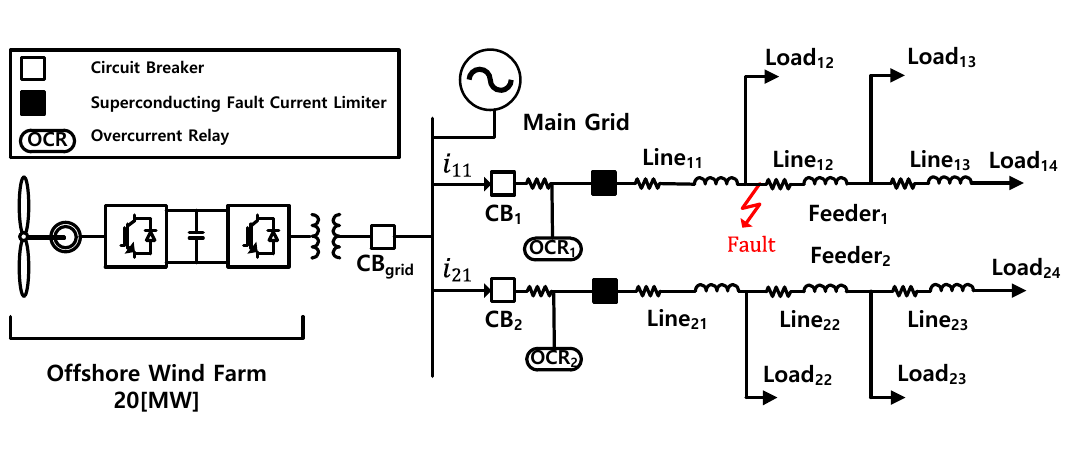
Figure 5. Configuration of offshore wind farm and grid connection with a superconducting fault current limiter